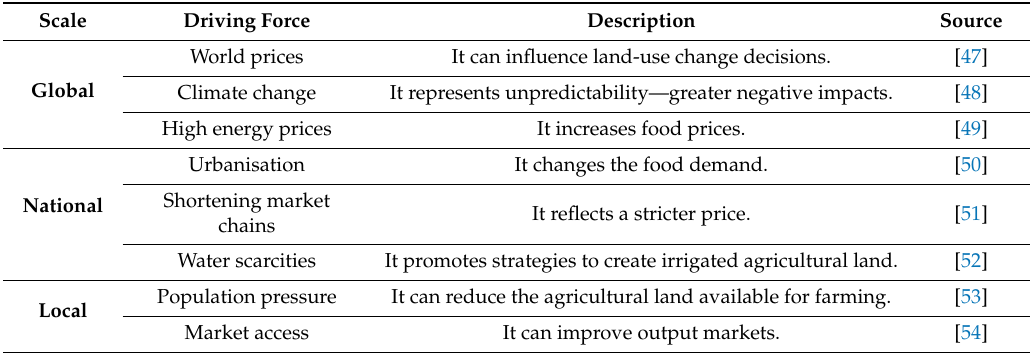
Table 1. Global, national, and local driving